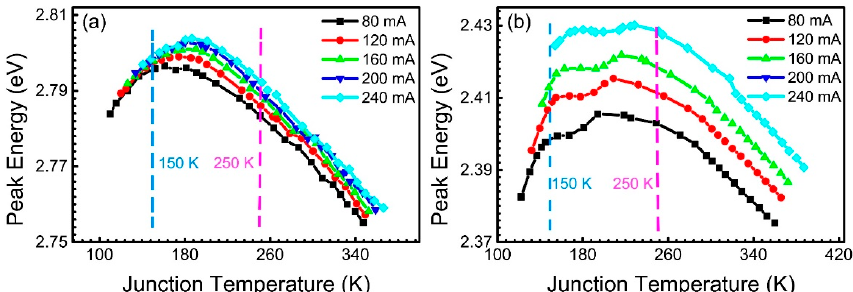
Figure 3. Normalized electroluminescence (EL) spectra at selected T j for the blue LED at ( a ) 80 mA and ( b ) 240 mA, and for the green LED at ( c ) 80 mA and ( d ) 240 mA.